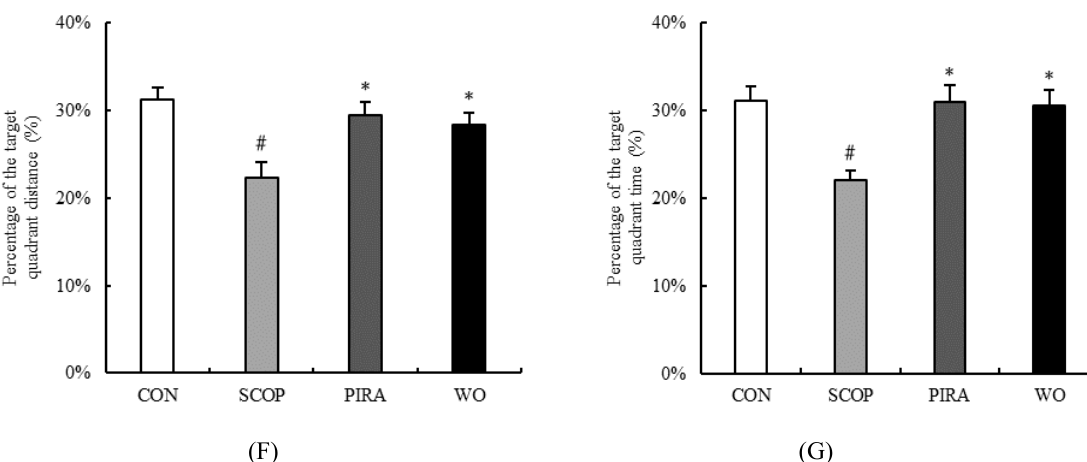
Figure 1. Effects of walnut oil on escape latency ( A ) and total swimming distance ( B ) from day1 to day 4, and number of platform crossing ( C ), time spent in the target quadrant ( D ), percentage of the target quadrant distance ( E ), percentage of the target quadrant time ( F ) and represent tracks of mice ( G ) on day 5 during the Morris water maze test. Data are shown as mean ± SEM. # p < 0.05 versus the control group. * p < 0.05 versus the SCOP-treated group.